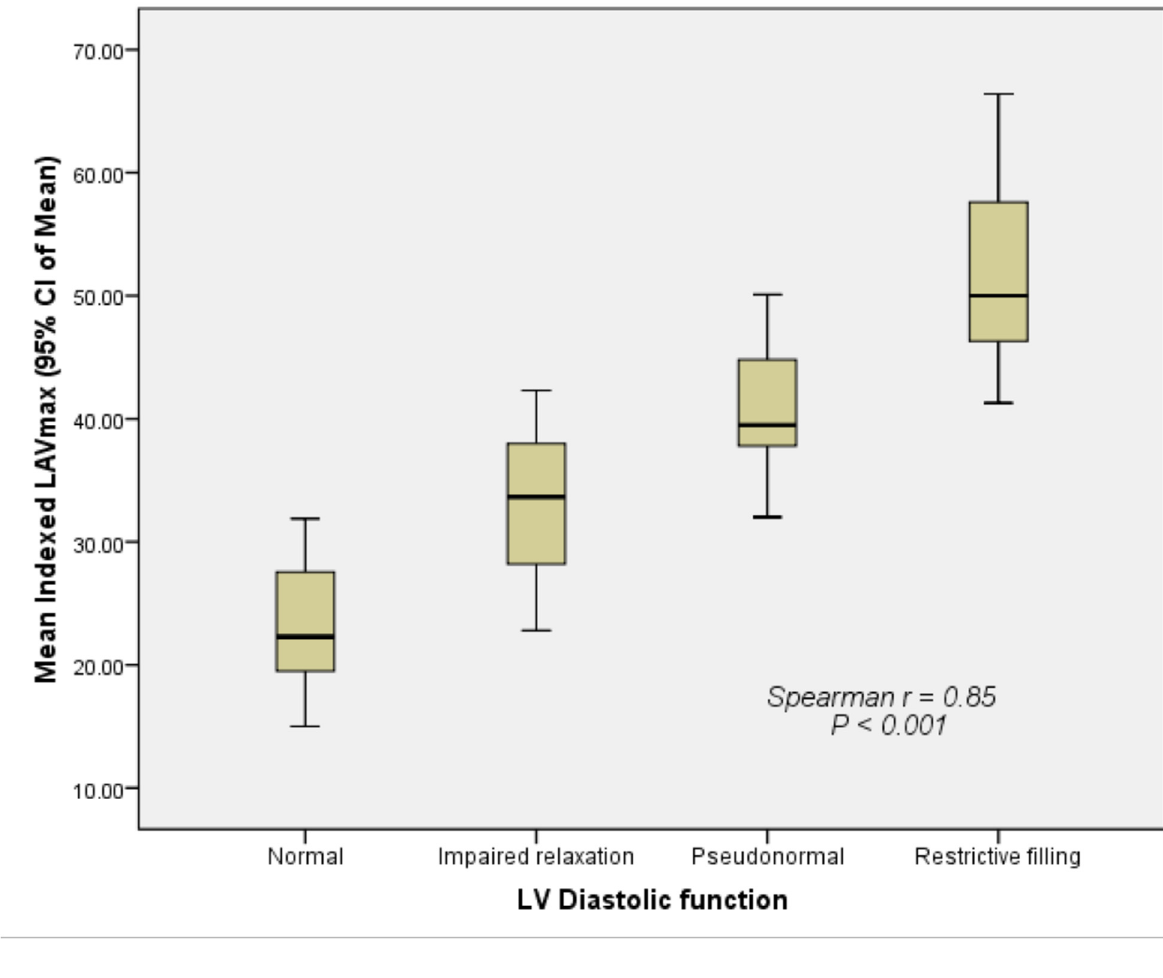
Fig 3. Correlation between the indexed LAVmax and different grades of left ventricular diastolic dysfunction. The indexed LAVmax increased significantly as LV diastolic dysfunction decreased ( P < 0.001).